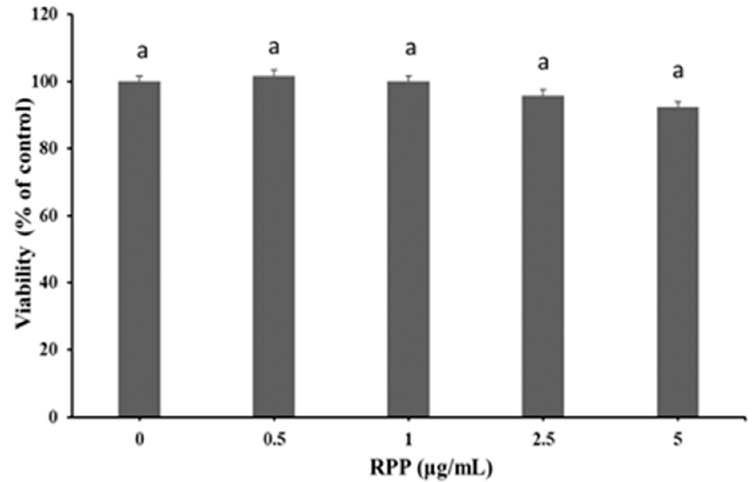
Figure 1. E ff ect of rambutan peel phenolic (RPP) on the viability of RAW264.7 cells. Groups with di ff erent letters are significantly di ff erent ( p < 0.05).